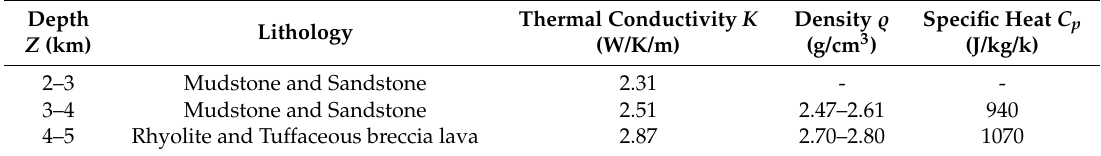
Table 1. Hot dry rock (HDR) resource reserves assessment and values of main parameters (Zhang et al. [8] and Wu